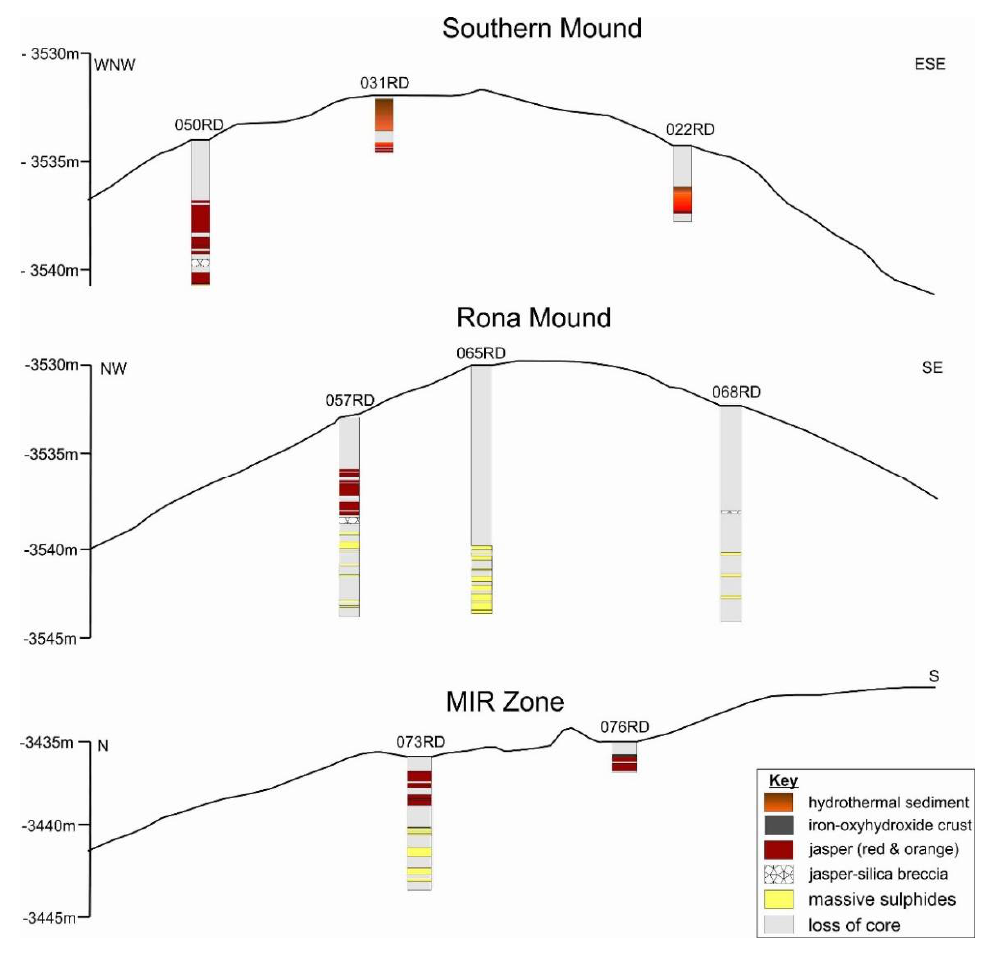
Figure 6. Schematic cross-Section through Southern Mound, Rona Mound, and MIR Zone, drilled during Blue Mining cruise JC138, using RD2 from the BGS.